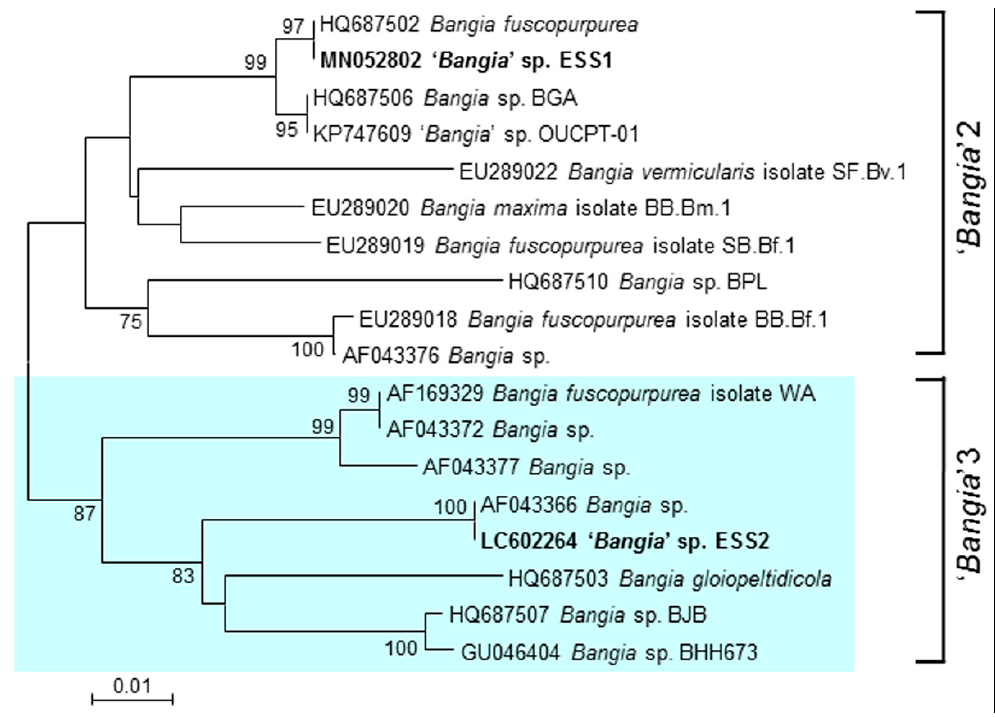
Figure 1. Phylogenetic identification of ‘ Bangia ’ sp. ESS2. The phylogenetic tree was constructed by the neighbor-joining method using sequences of rbcL genes from different species from the ‘ Bangia ’ 2 and ‘ Bangia ’ 3 groups identified by Sutherland et al. [10]. The DDBJ/EMBL/GenBank accession numbers of the rbcL gene sequences are shown in front of the species names. ‘ Bangia ’ sp. ESS1 and ‘ Bangia ’ sp. ESS2 are highlighted. Bootstrap values over 50% from 1000 replicates are indicated at the nodes. Bar, 0.01 substitutions per site.